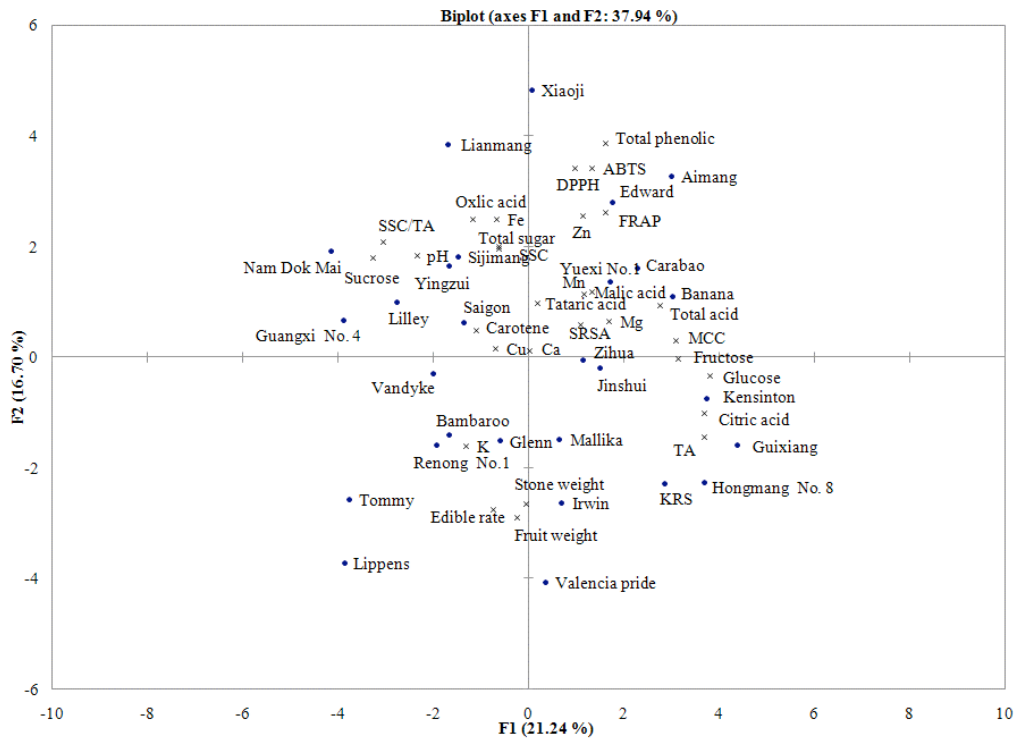
Fig. 1: Segregation of 28 mango genotypes according to their quality characteristics determined by principal component analysis